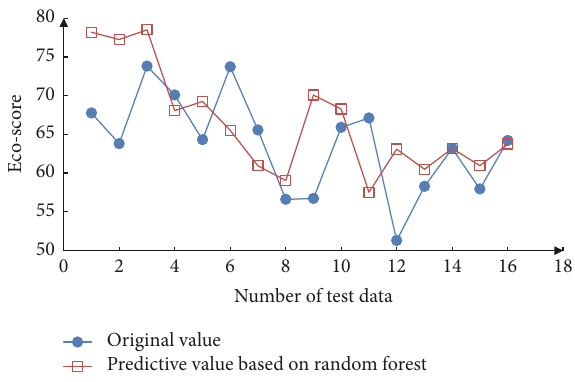
Figure8:Relationshipbetweenoriginalvaluesandpredictivevalues based on linear regression model.